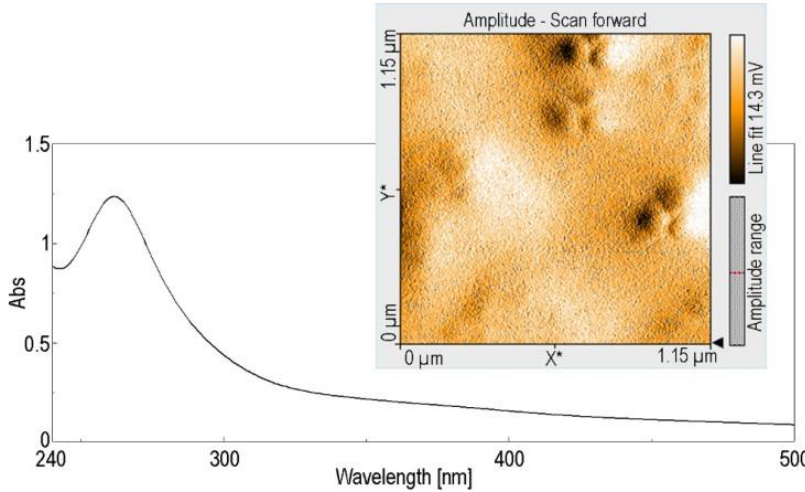
Figure 7. The UV-Vis spectrum and the 2D AFM image of the PtNPs.